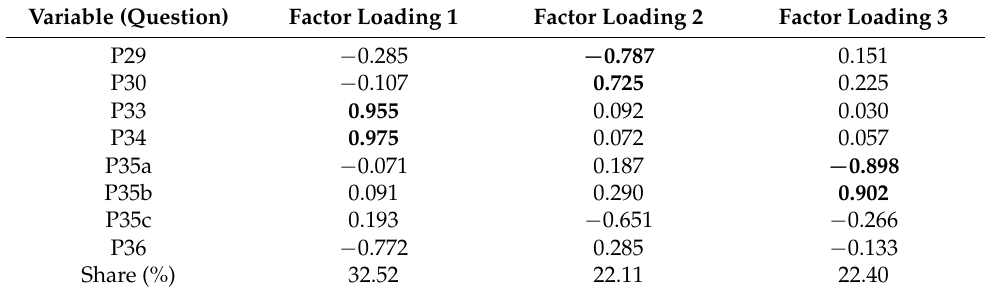
Table 3. Results of principal component analysis for supply chains and function performance. Variable